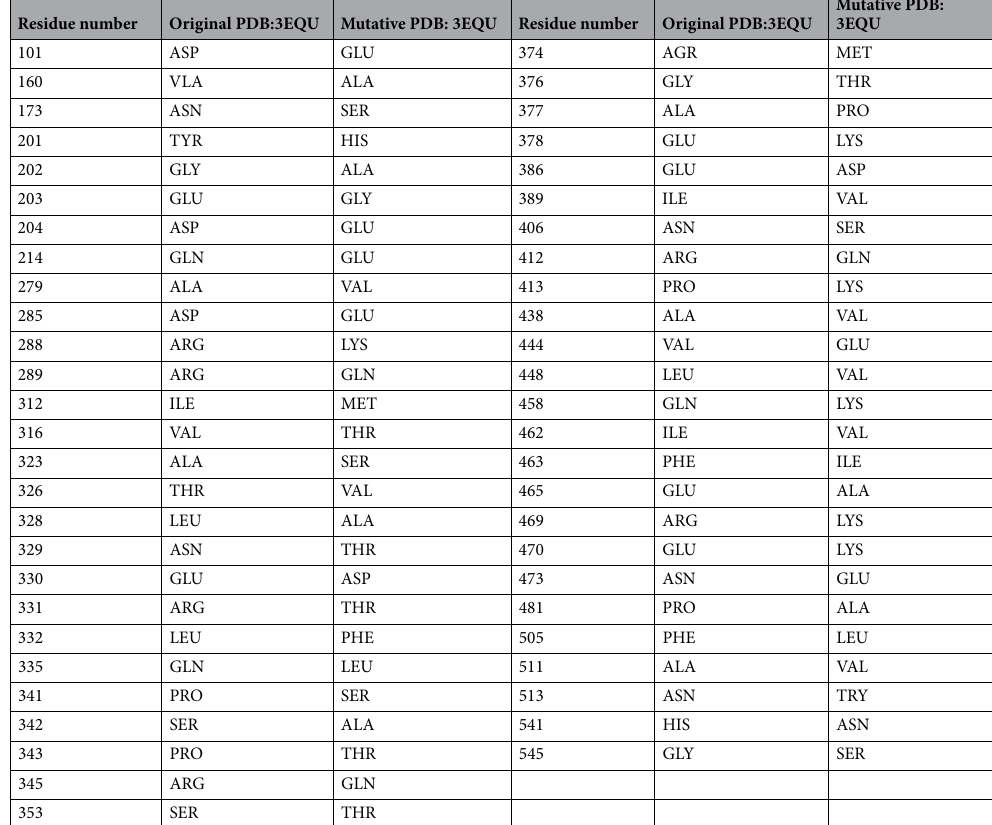
Table 3. The amino acid residues in wild type N. gonorrhoeae Penicillin- binding proteins (PBPs) and mutative in Penicillin- binding proteins (mPBPs) in N. gonorrhoeae clinical isolates NG-083 and NG-091 with reduced susceptibility to ceftriaxone (n = 2), Thailand,